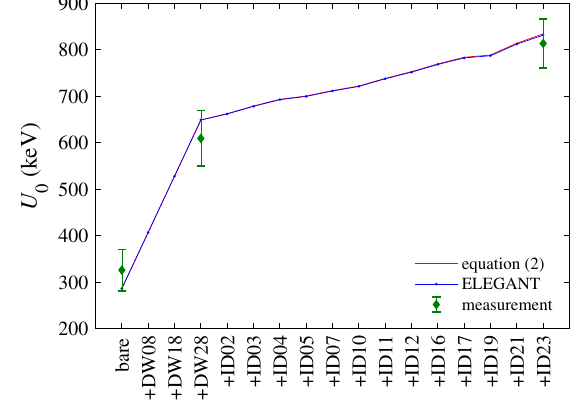
FIG. 6. Radiation energy loss vs ID